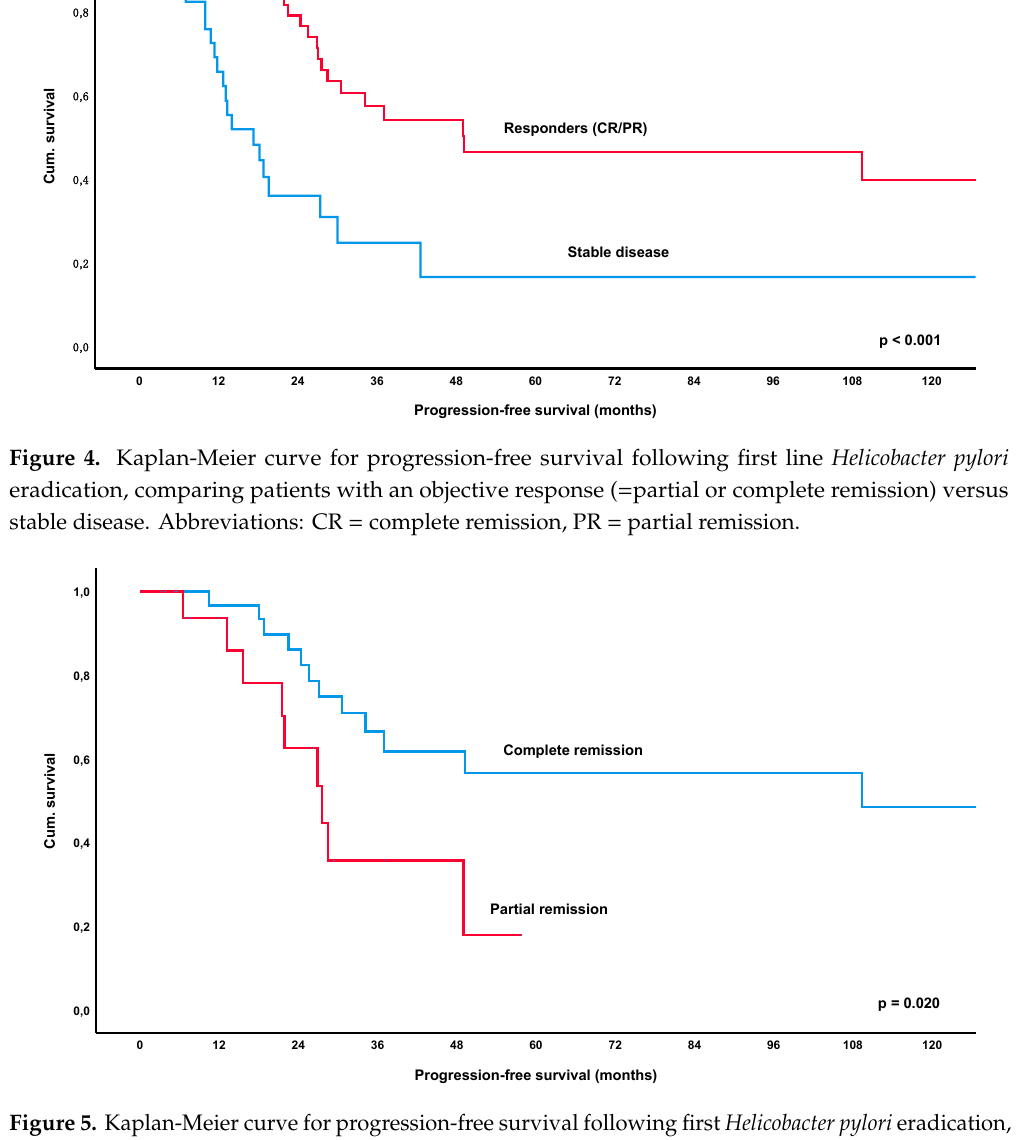
Figure 5. Kaplan-Meier curve for progression-free survival following first Helicobacter pylori eradication, comparing patients with complete remission versus patients achieving partial remission.